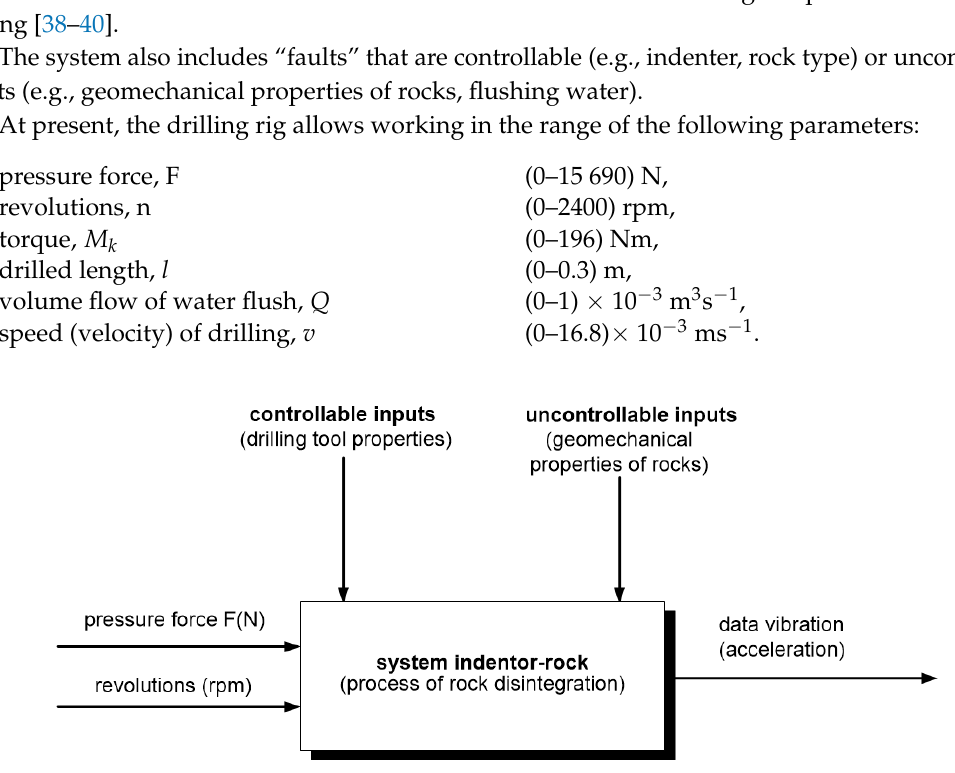
Figure 2. Scheme of the tool-rock